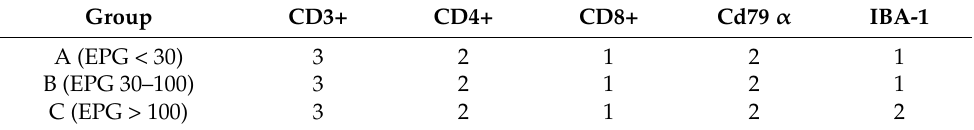
Table 3. Median for each group for each inflammatory cell’s